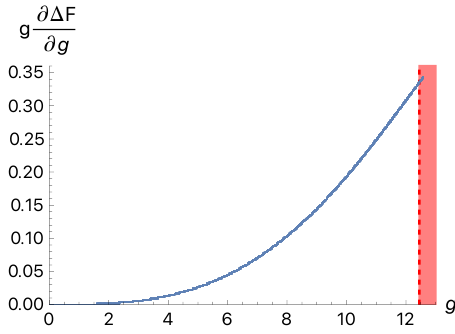
Figure 10 . Difference between the free energy in the UV and the free energy in the IR at d = 3 . The red area corresponds to g > g c